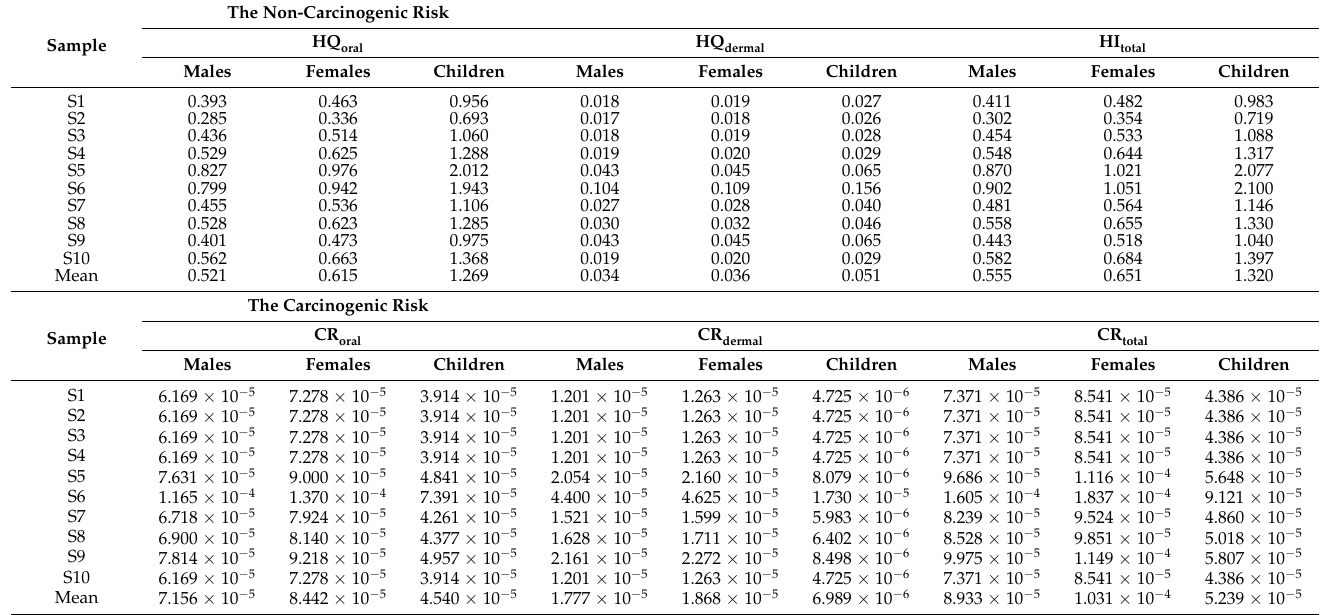
Table 6. The non-carcinogenic and carcinogenic risk results from drinking water and dermal